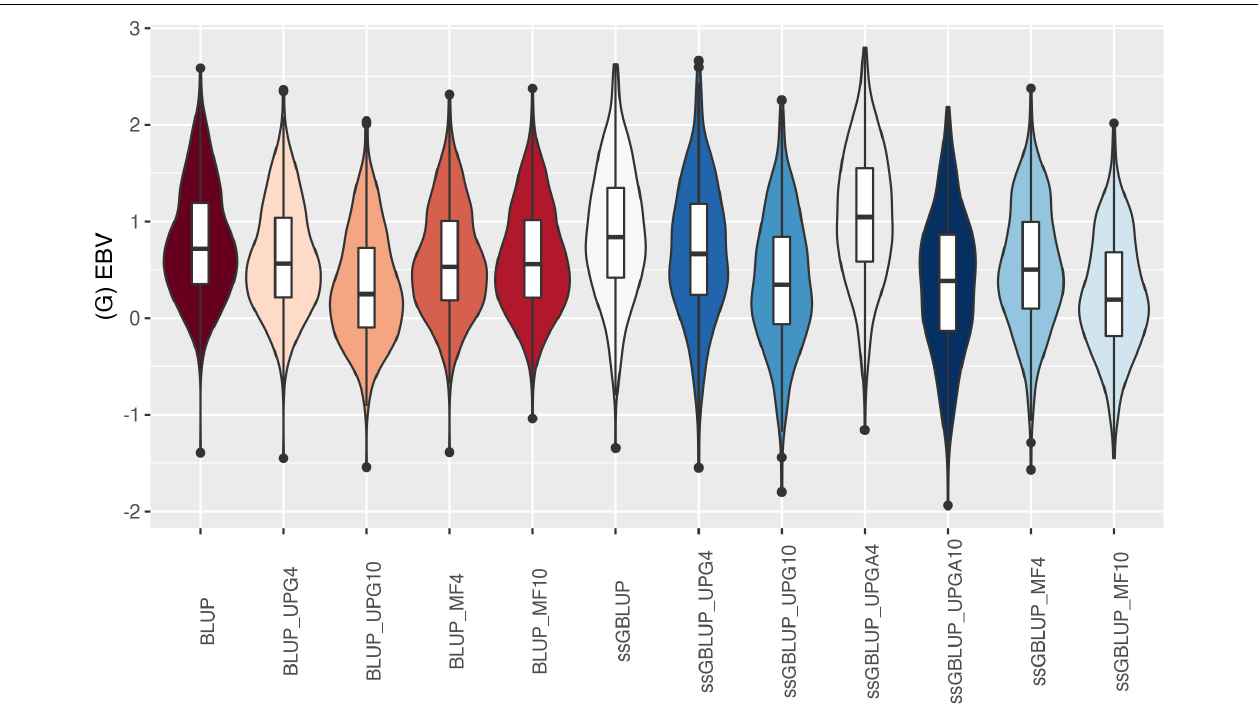
FIGURE 7 | (G)EBVs for validation animals for scrotal circumference at 14 months of age estimated using various models with and without genetic groups. (G)EBVs, (genomic) estimated breeding values.